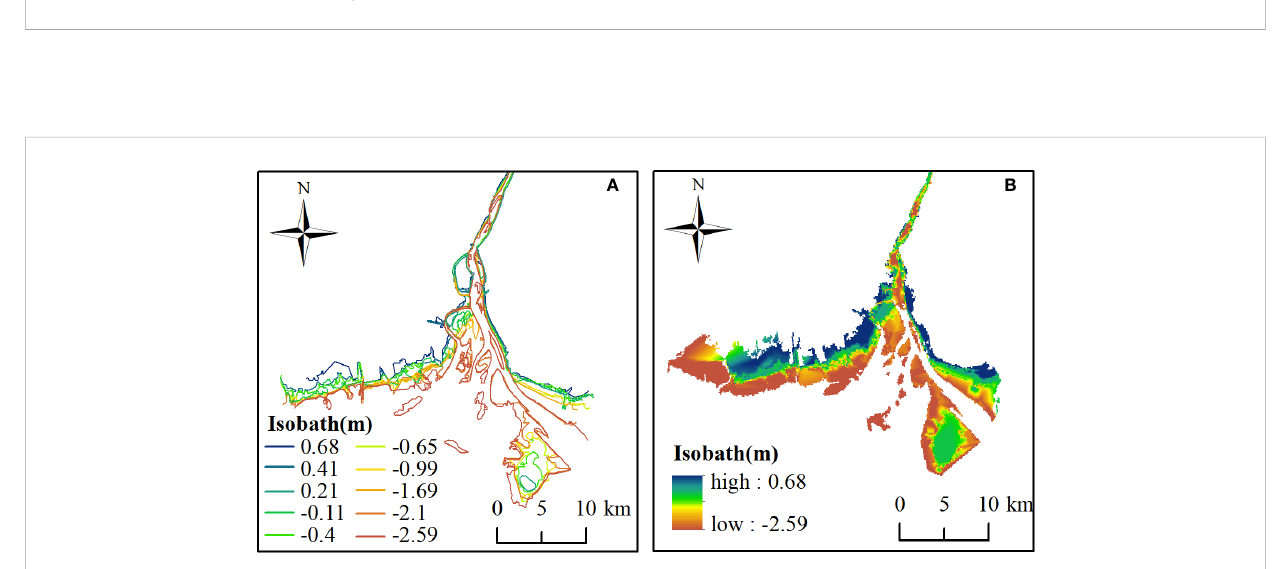
FIGURE 3 The extracted waterlines (A) and interpolated DEM (B) in 2015.